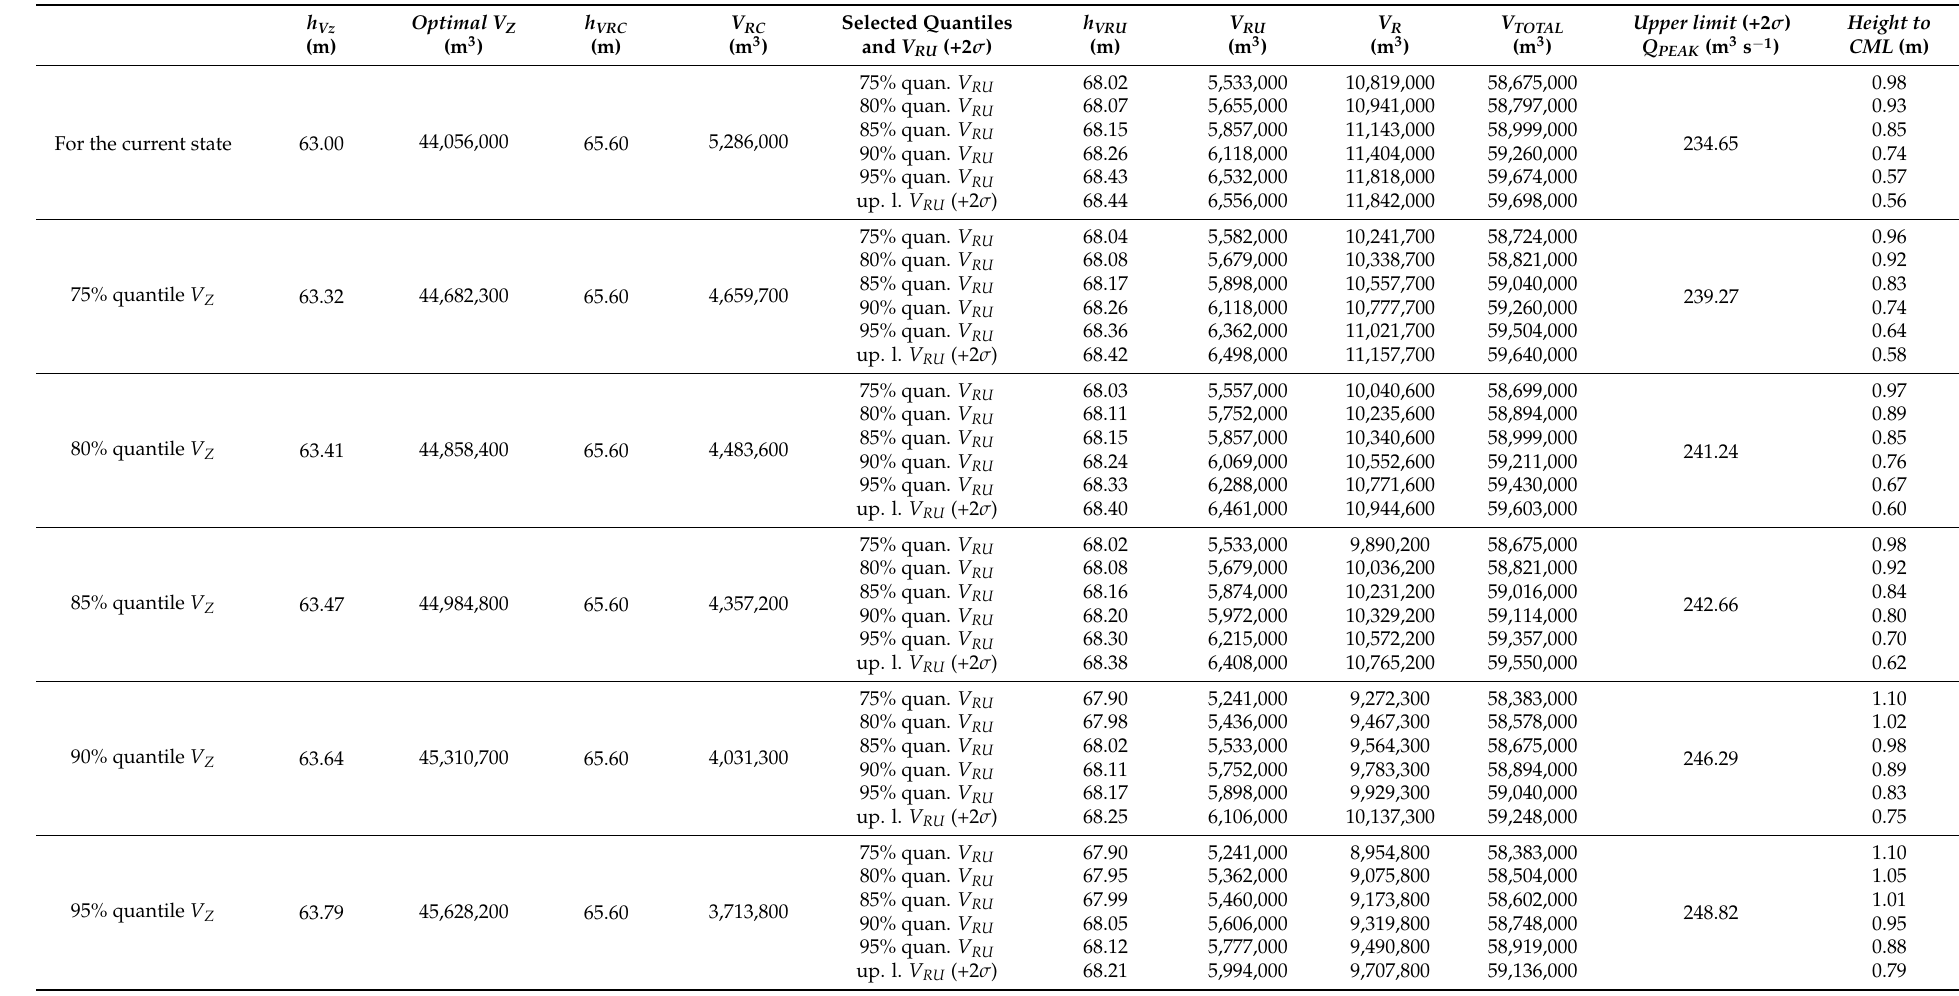
Table 6. The calculated volumes of water in the reservoir and their corresponding heights for selected optimal V Z values (m 3 ), including the sizes of peaks of transformed flood discharges Q 1000 for selected quantiles and the upper limit +2 σ